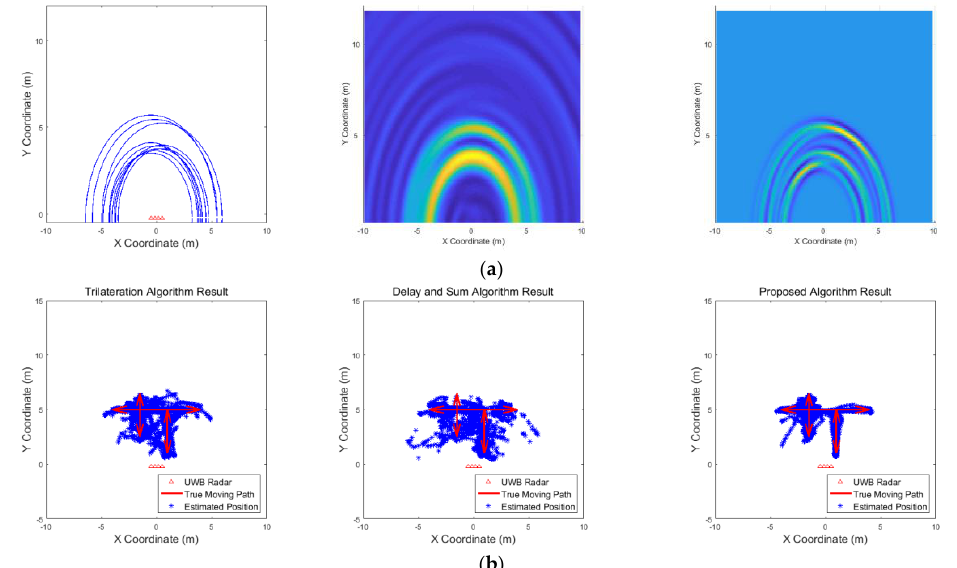
Figure 13. Simulation results when two targets move (Scenario 5): ( a ) instantaneous results of position estimation step according to the positioning algorithm; ( b ) results of the radar system for the entire simulation.